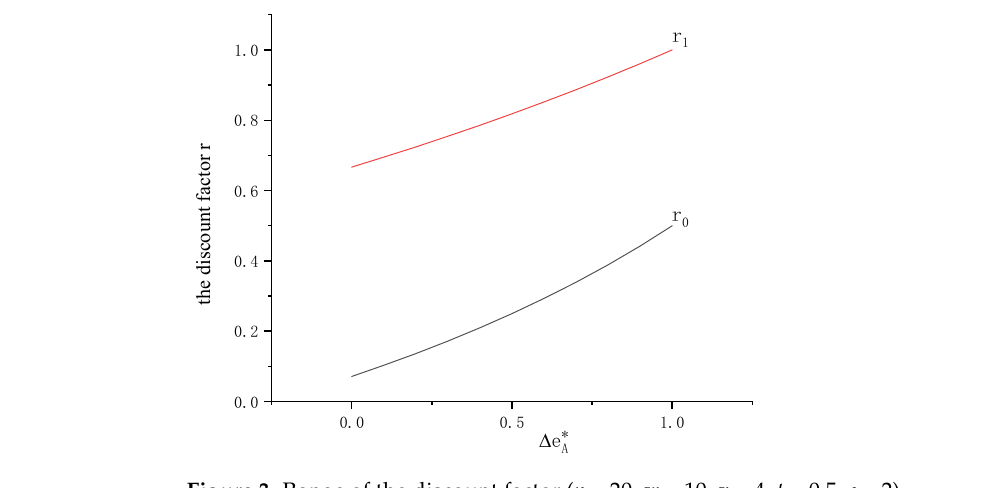
Figure 3. Range of the discount factor ( p = 20, w = 10, v = 4, t = 0.5, e = 2).